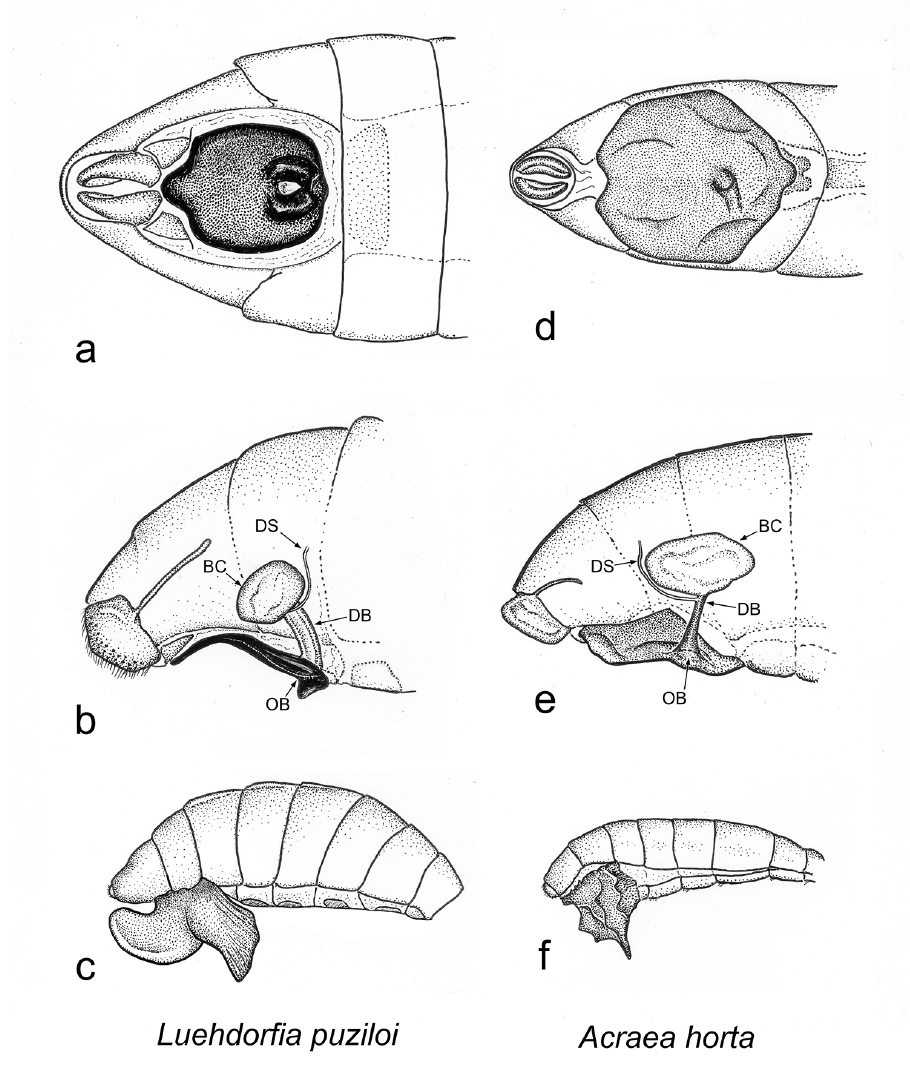
Figure 37. Ventral and parasagittal views of the female genitalia and lateral abdomen with sphragis for Luehdorfia puziloi ( a, b, c respectively), and Acraea horta ( d, e, f respectively), showing convergence in ex- ternalization of female genitalia, reduction in the size of the bursa copulatrix, and how the genitalia is cov- ered by the sphragis. BC, bursa copulatrix, DB, ductus bursae; DS, ductus seminalis; OB, ostium